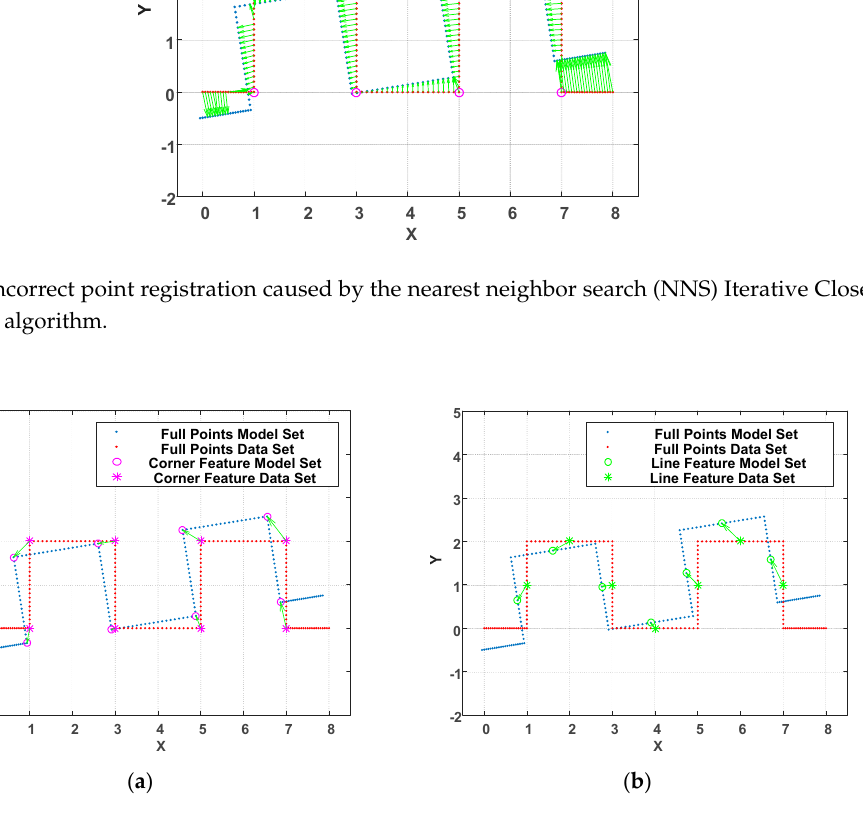
Figure 6. Illustration of feature-based point cloud registration. ( a ) Corner features are matched to corresponding corner features ( b ) Line features are matched to corresponding line features.